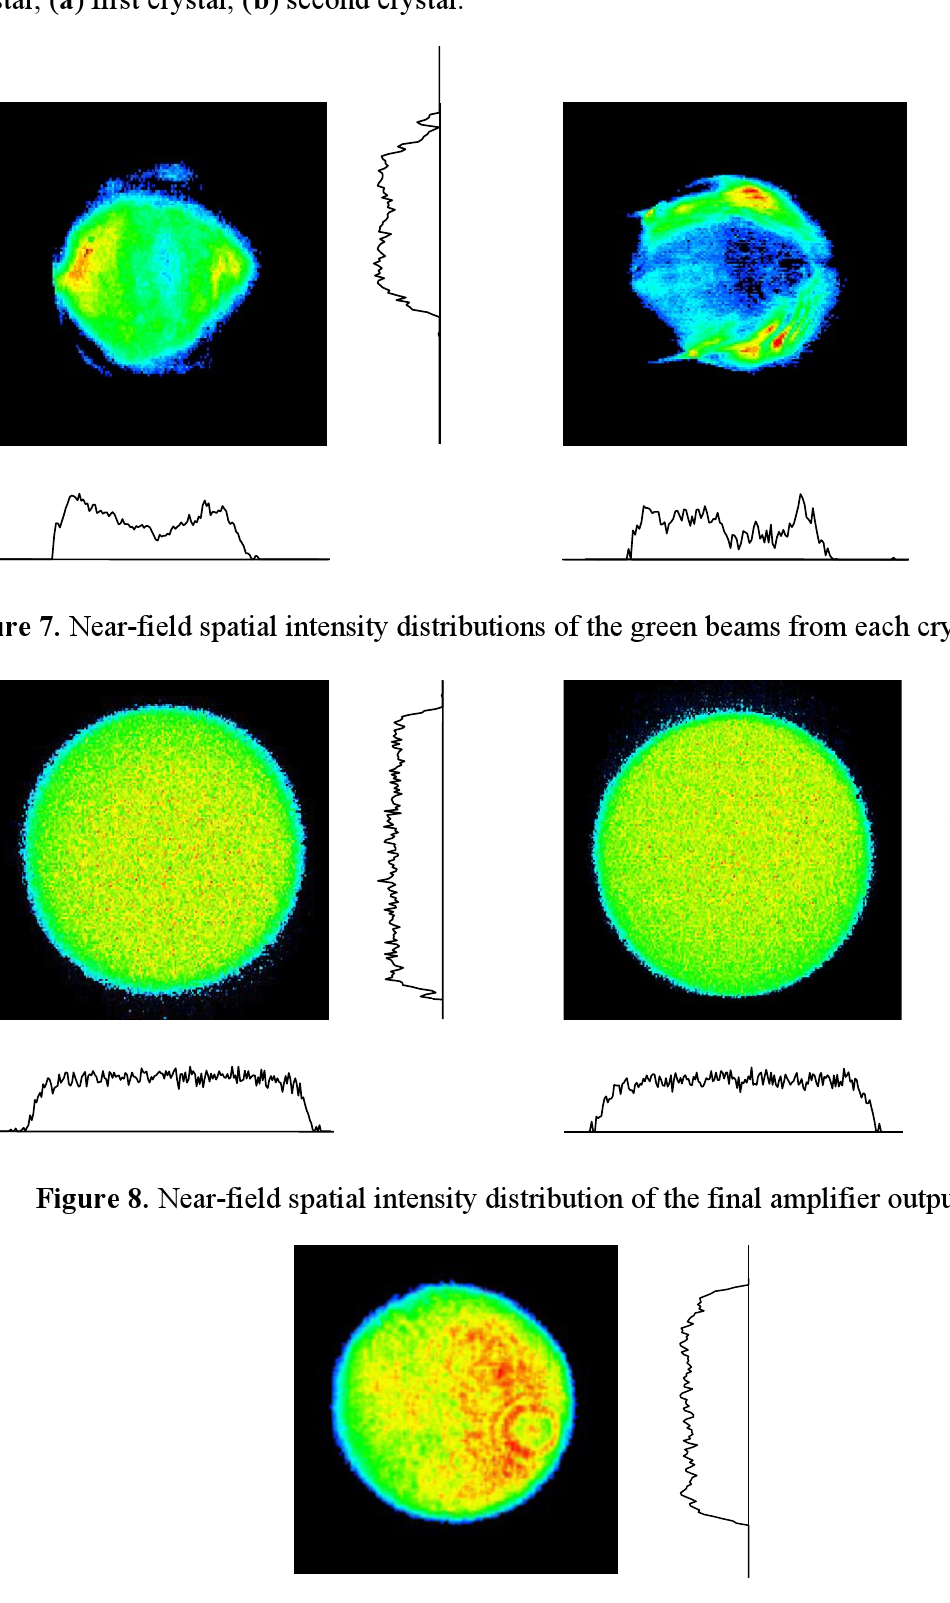
Figure 6. Near-field spatial intensity distributions of the green beams from each DKDP crystal; ( a ) first crystal, ( b ) second crystal.